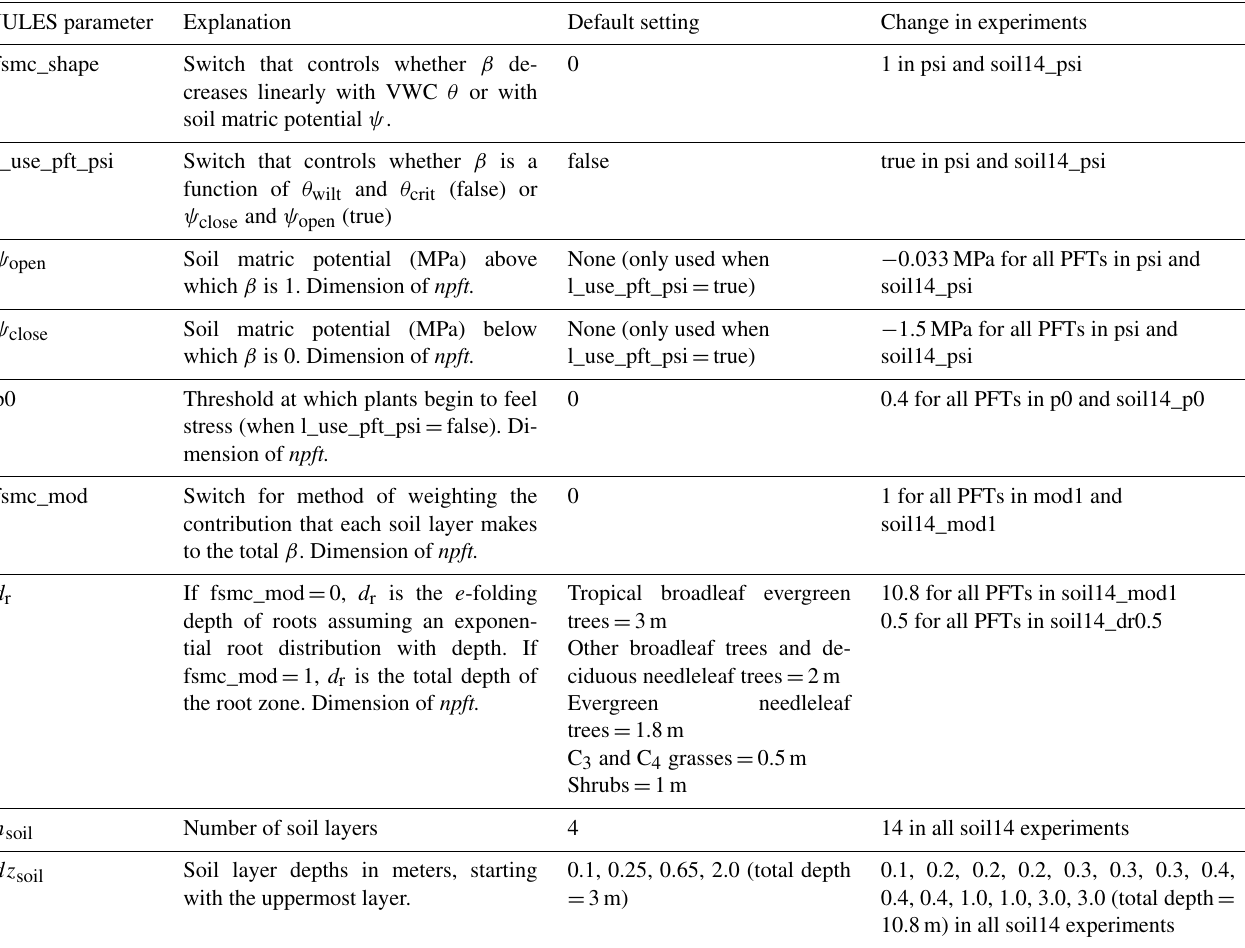
Table 2. Default parameter settings (changed in experiments summarized in Table 1). In the JULES code, p0 is called fsmc_p0, n soil is called sm_levels, d r is called rootd, ψ open is psi_open, and ψ close is